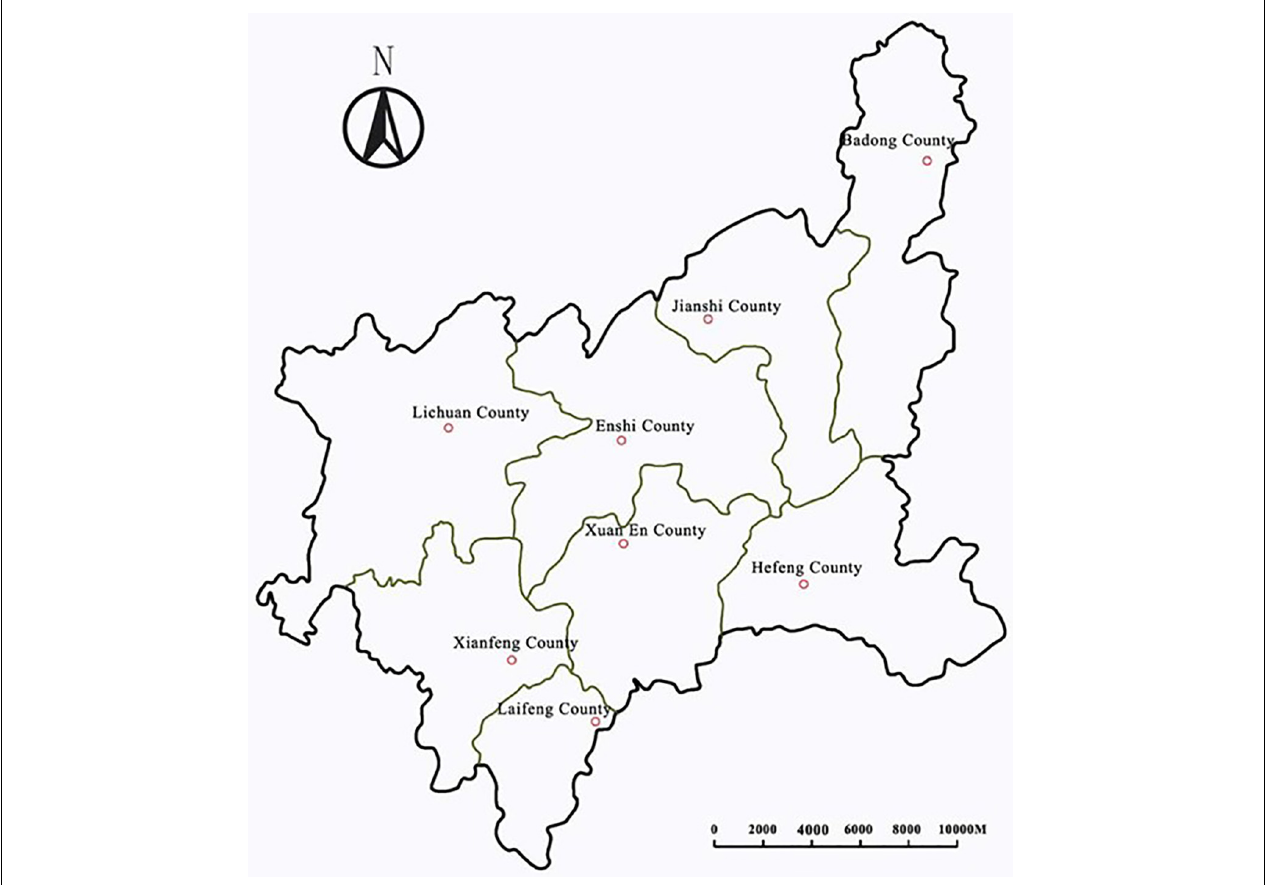
FIGURE 1 | Regional distribution map of eight counties in Enshi Autonomous Prefecture (EAP),